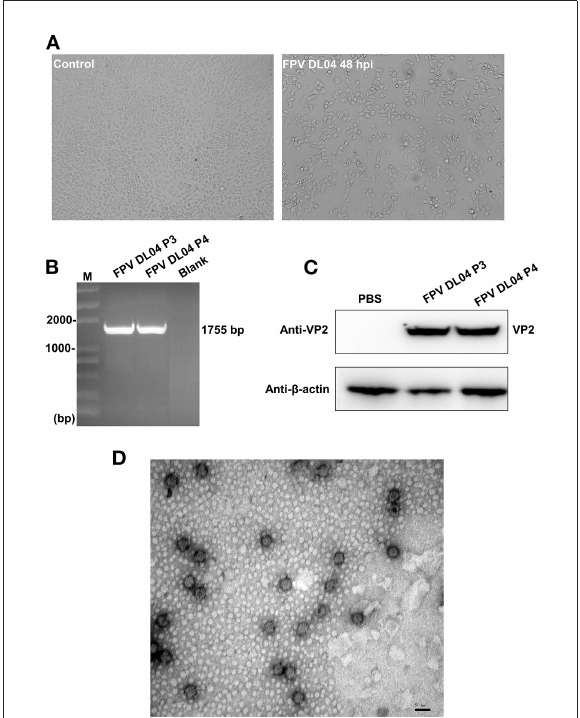
FIGURE4 Isolation and identification of the FPV DL04 strain. (A) Cytopathic effect (CPE) of F81 cells infected with the FPV DL04 strain at 48 hpi ( × 100). The control F81 cells were mock infected with the isolated virus ( × 100). (B) VP2 PCR analysis of the total cell DNA from the third and four passages of virus-infected cells or uninfected cells. (C) Western blot analysis of the total cell lysates from virus-infected cells using rabbit anti-VP2 polyclonal antibodies and anti- β -actin mouse monoclonal antibodies. (D) Transmission electron microscopy image of the purified isolate negatively stained with 3% phosphotungstic acid. The scale bar represents